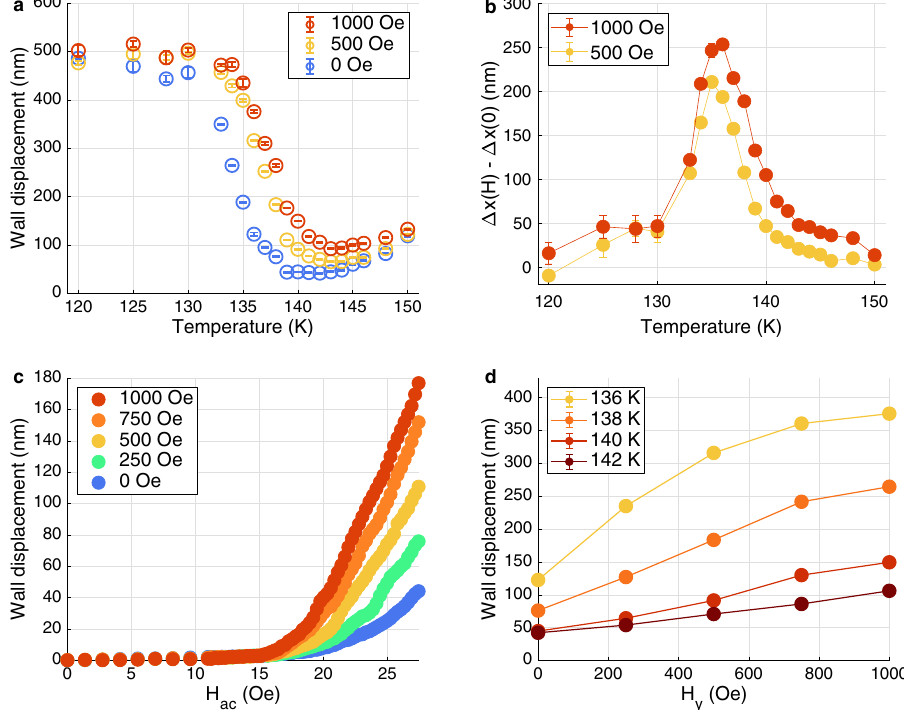
Fig. 3 Magnetic fi eld dependence of the DW ellipticity. a DW displacement plotted against temperature for various in-plane dc magnetic fi eld H y applied to the sample. b The changes in DW displacement Δ x induced by dc fi eld values of H y ¼ 500 Oe and 1000 Oe show sharp peaks at T ¼ 135 K and 136 K , indicating a phase transition into the linear wall state, c DW displacement versus H ac for different values of in-plane dc fi elds H y at T ¼ 139 K. A clear change in the DW displacement and mobility is observed by tuning the wall ellipticity with an in-planed fi eld H y applied to the sample near T BG . d DW displacement plotted versus in-plane fi eld H y for various temperatures. A saturation behavior is observed at lower temperatures toward the Bloch wall